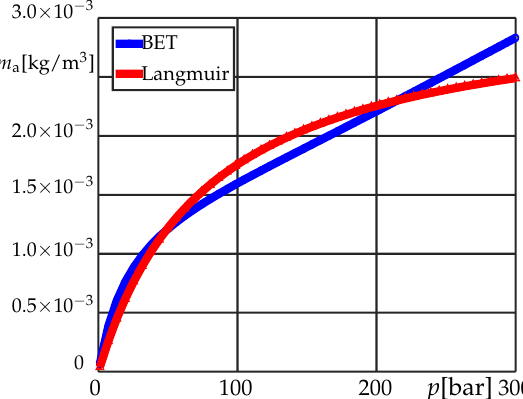
Figure 4. Langmuir and BET isotherms for V L = 0.0031 m 3 /kg, P L = 7.89 MPa, T = 327.59 K, P s = 53.45 MPa, V m = 0.0015 m 3 /kg, C = 24.56, and n = 4.46.